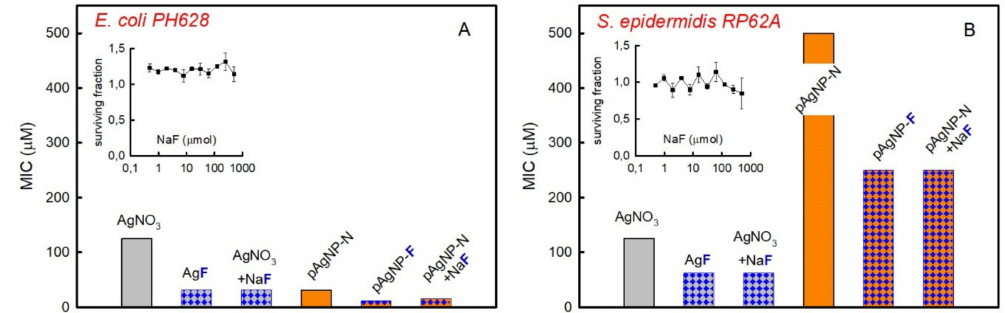
Figure 2. Minimum inhibitory concentration (MIC) values for treatments on planktonic bacteria. ( A ): E. coli PH628 , grey bars refer to the e ff ect of ionic silver and orange bars to the e ff ect of pAgNP, blue checkers visually evidence data for treatments containing F − ; ( B ): same, for S. epidermidis RP62A. Insets: surviving fraction vs micromolar concentration of NaF on treatment with the pure sodium salt for E. coli PH628 ( A ) and S. epidermidis RP62A ( B